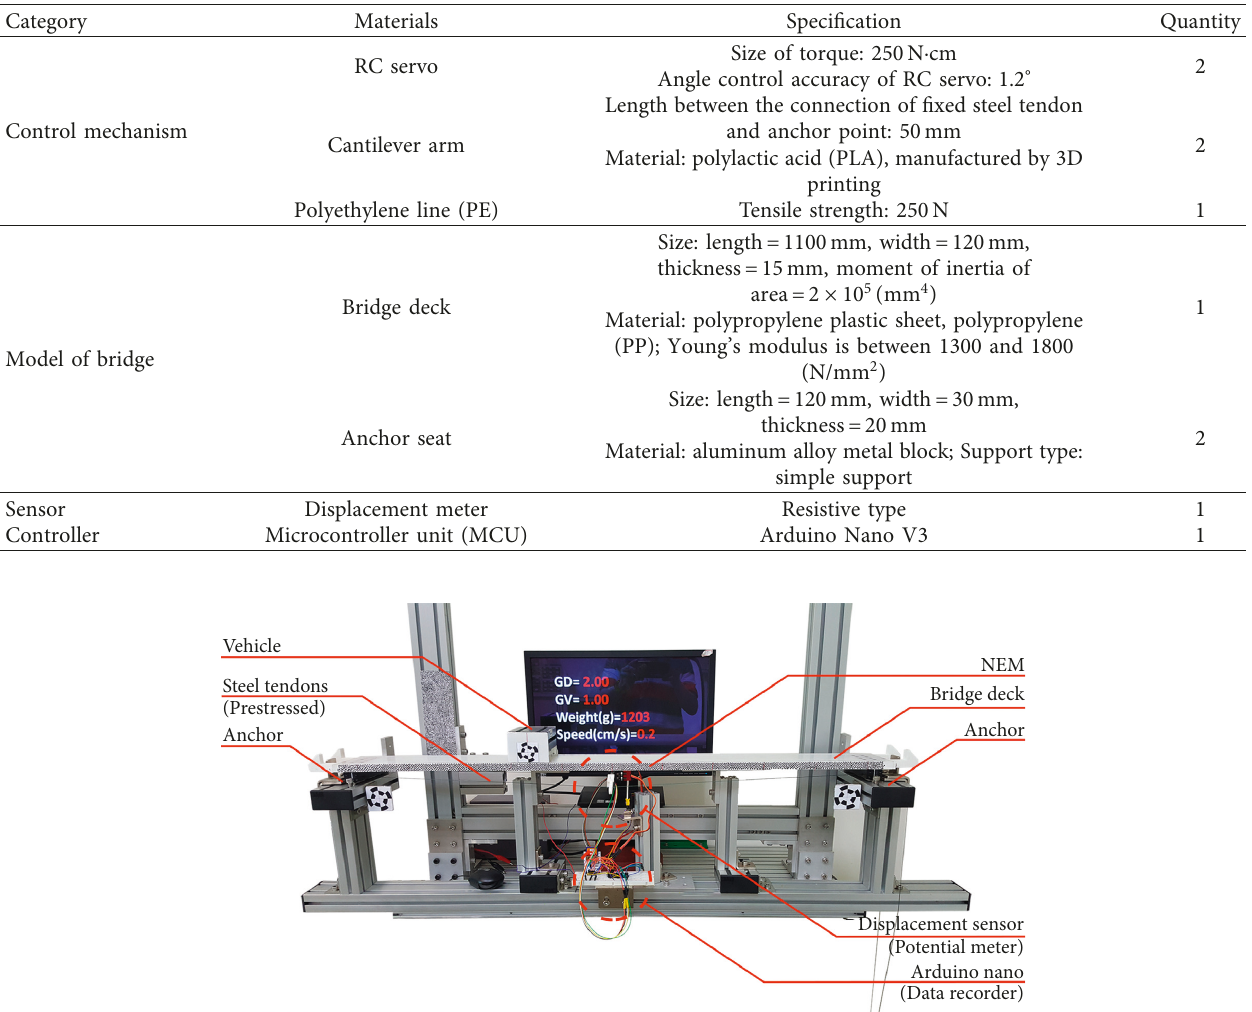
Table 2: Materials and specification of reduced scale of this test.